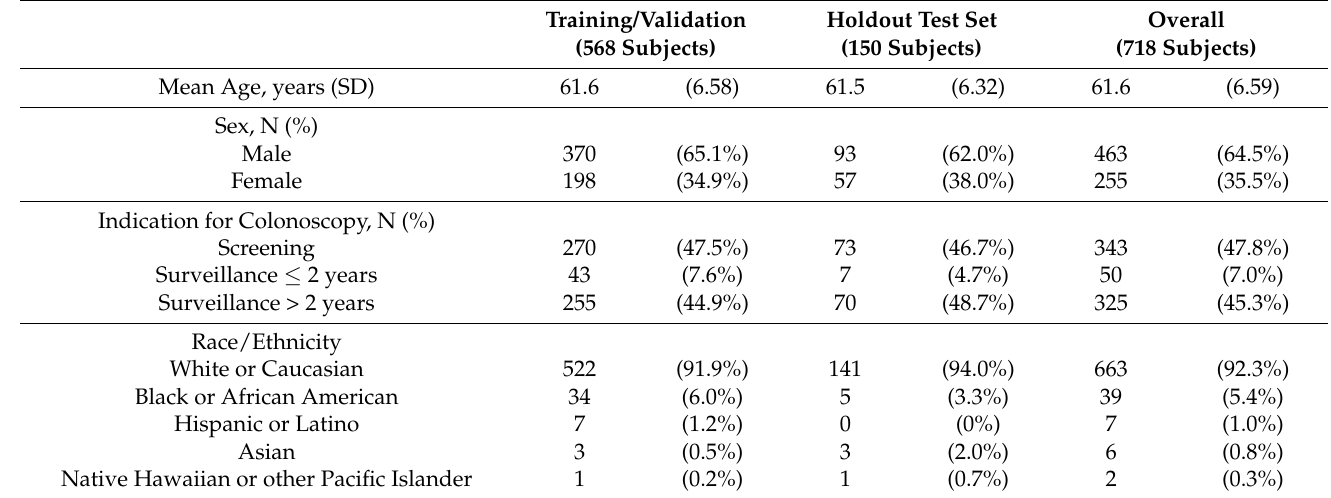
Table 1. Demographics and reasons for colonoscopy of the patients used for training, validation, and testing during the development of GI Genius CADe v1. The patients were derived from